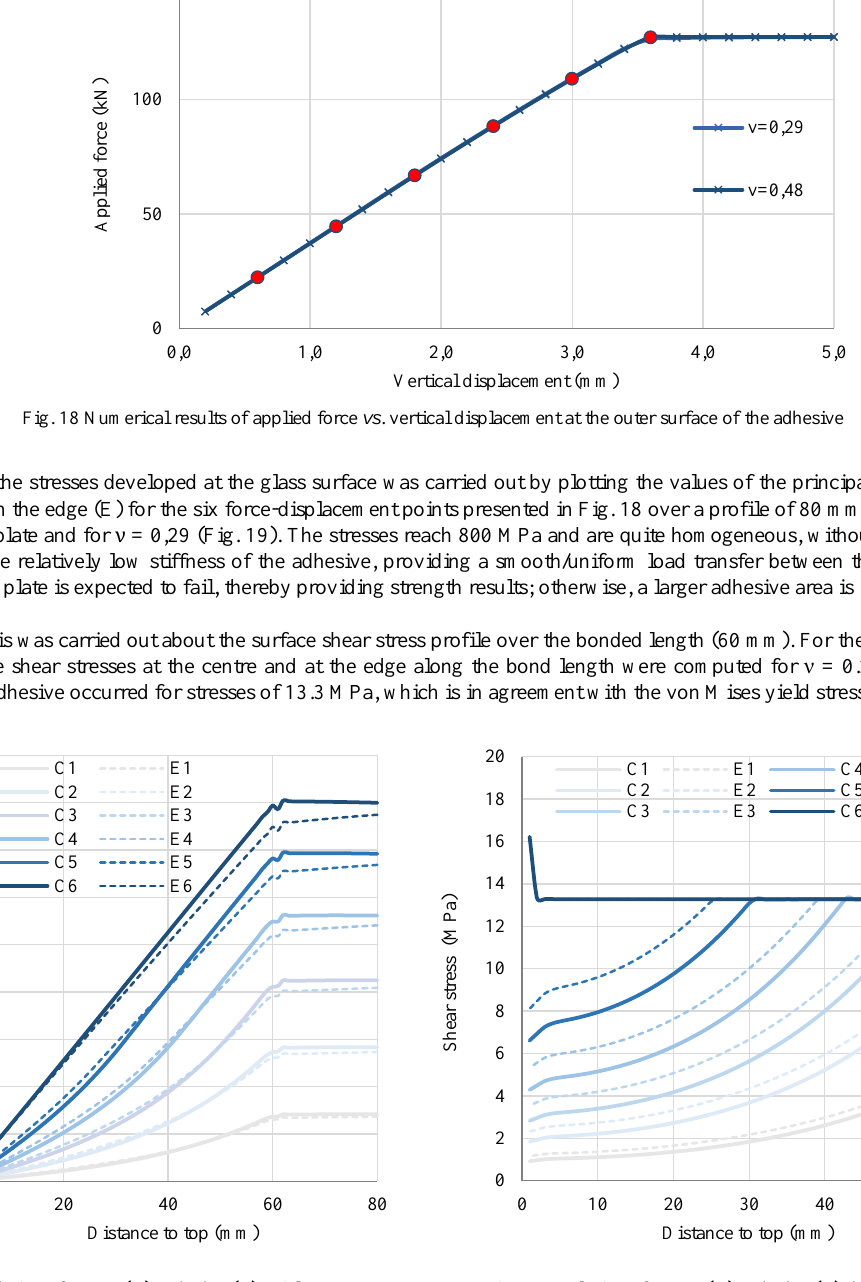
Fig. 20 Evolution of centre (C) and edge (E) shear stresses in the adhesive, vertical profile ( ν =